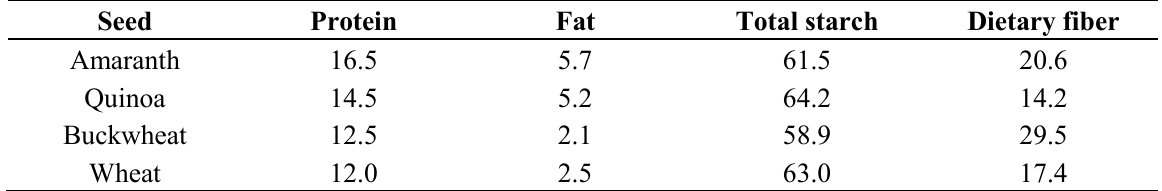
Table 12. Chemical composition of amaranth, quinoa, buckwheat in comparison to wheat seeds